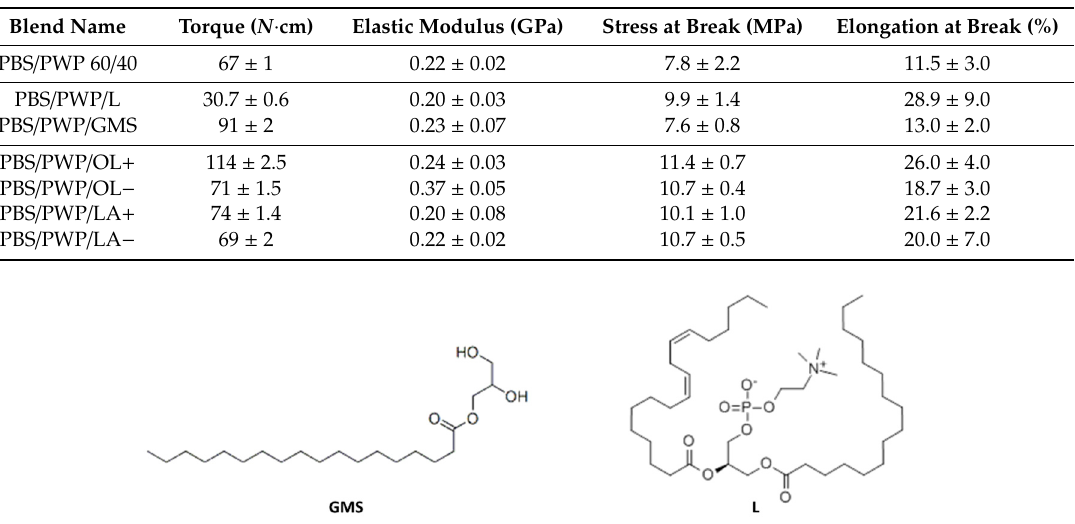
Table 2. Torque values and tensile properties of PBS/PWP 60/40 blend containing different compatibilizers.